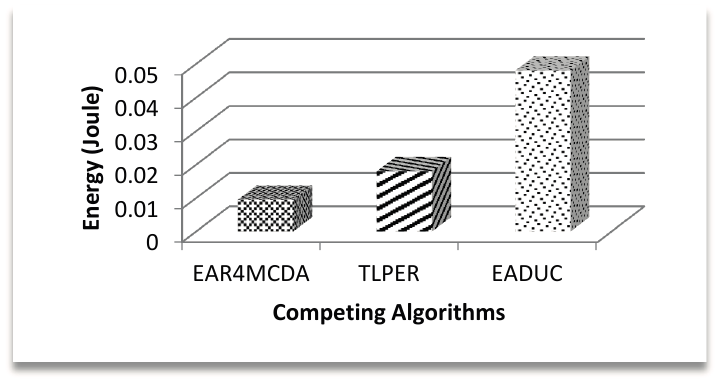
Figure 8. Average energy consumption in forwarding node